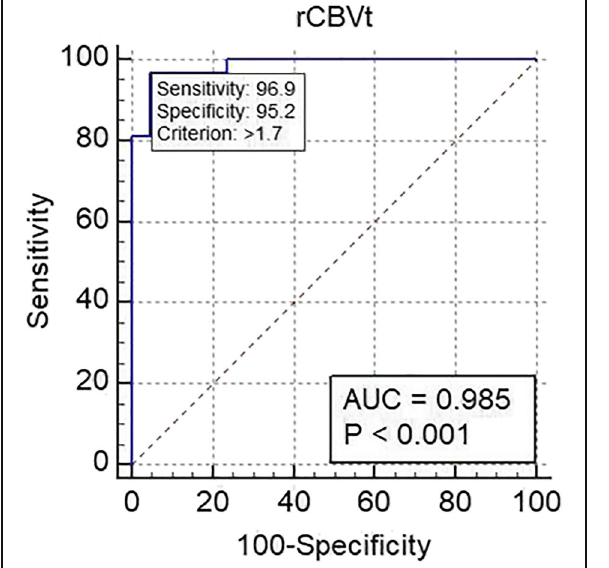
Fig. 4 ROC Curve rCBVt